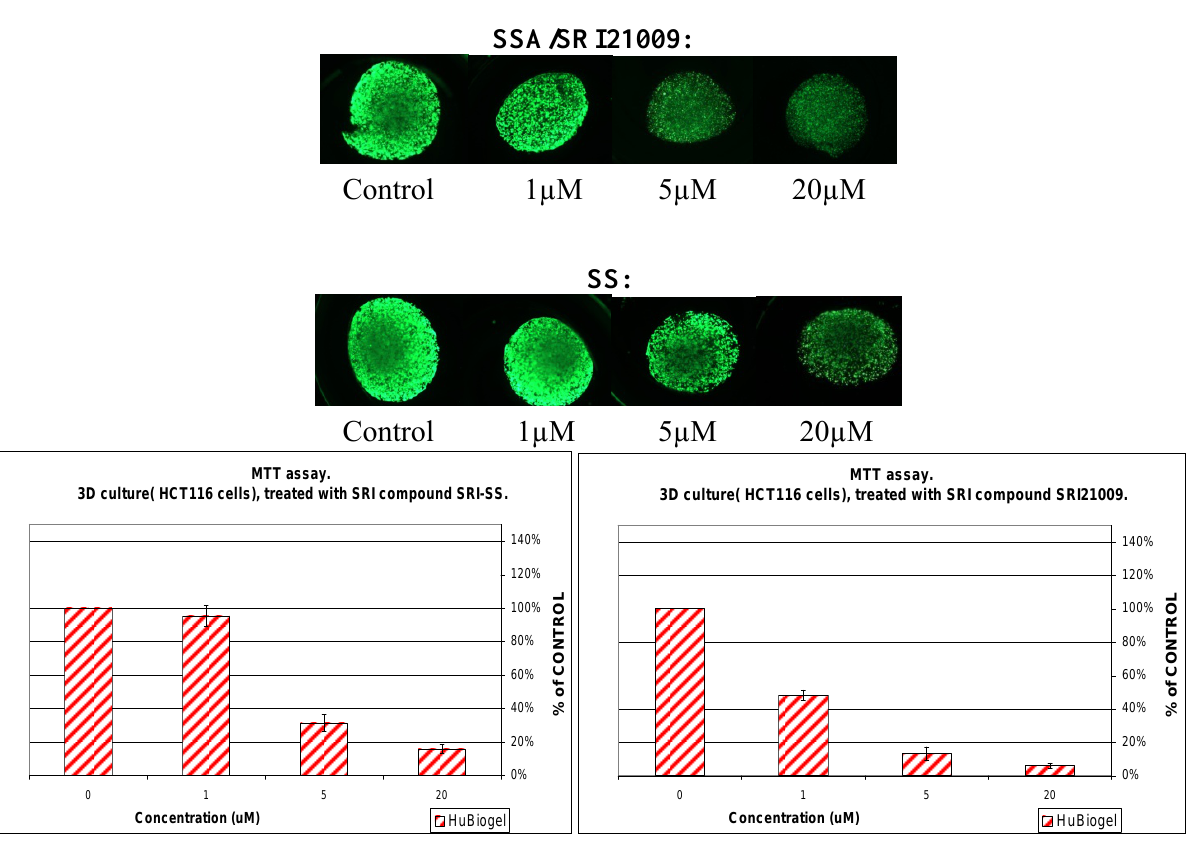
Figure 5. Inhibition of human HCT116 colon tumor cell growth in a 3-dimensional spheroid model by sulindac sulfide and sulindac sulfide amide (SRI